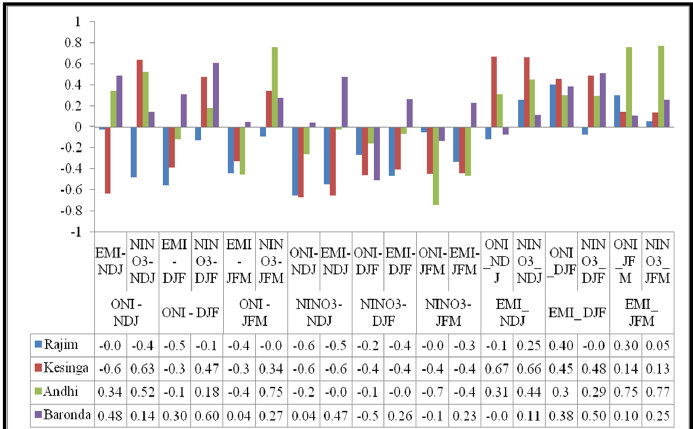
Figure 3. Partial correlation of Oceanic Nino Index (ONI), EMI and Nino3 with streamflow anomalies at four selected stations in JJA season. Here it is to be noted that partial correlation between streamflow and ONI has excluded the influence of EMI and Nino3. The same process was done to EMI and Nino3.